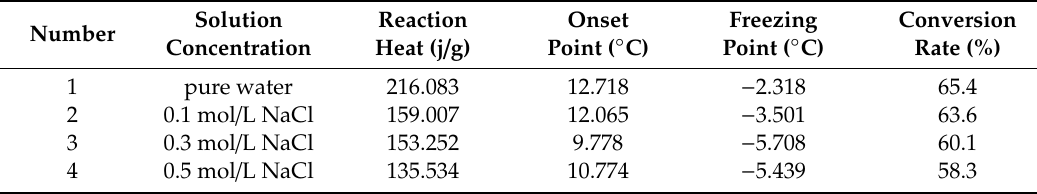
DSC experimental results of montmorillonite samples soaked in NaCl solution of di ff erent